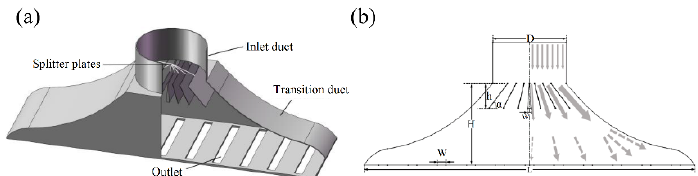
Figure 3. Improved inlet header (Configuration C): ( a ) Construction; ( b ) design parameters.